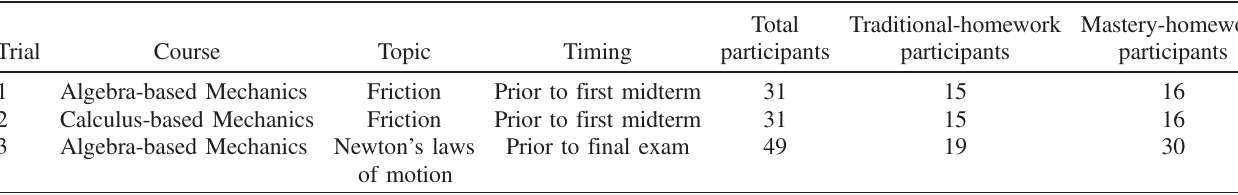
TABLE I. Summary of the three clinical trials.